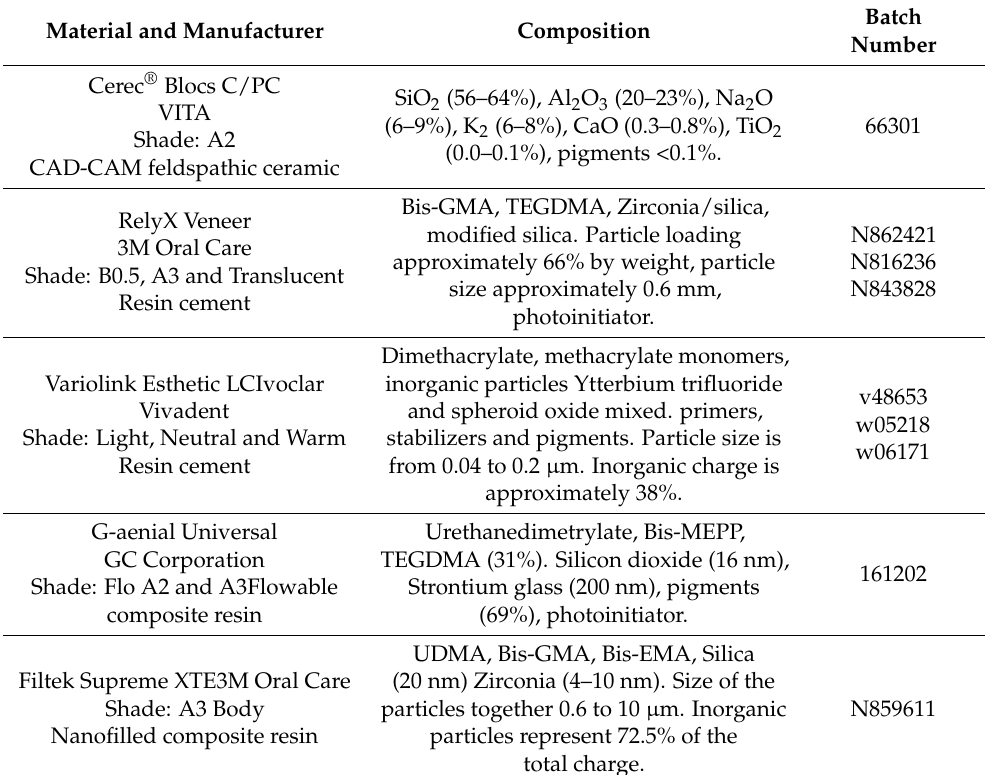
Table 1. Manufacturer and composition of ceramic, resin-based material and composite resin